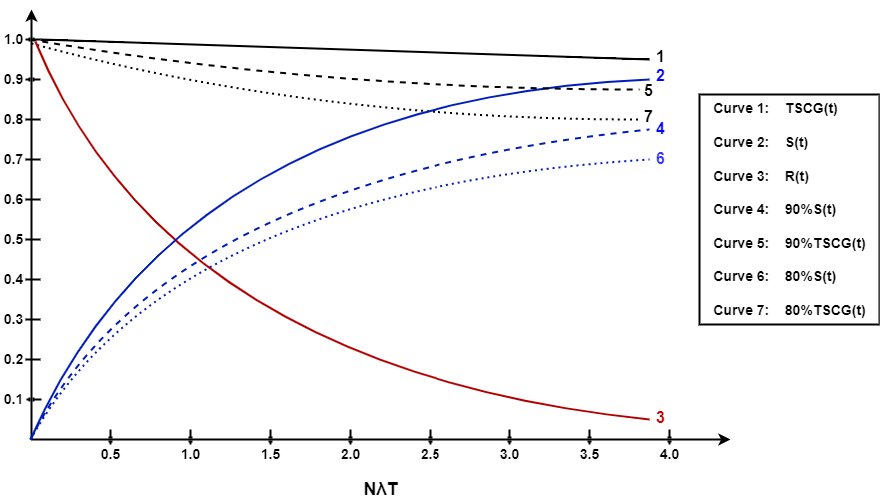
Figure 10. TSCG ( t ) when inputs have the same probability of occurrence but part of the inputs are not available: (1) all input values are available, (5) a case of 90% input values available, and (7) a case of 80% input values